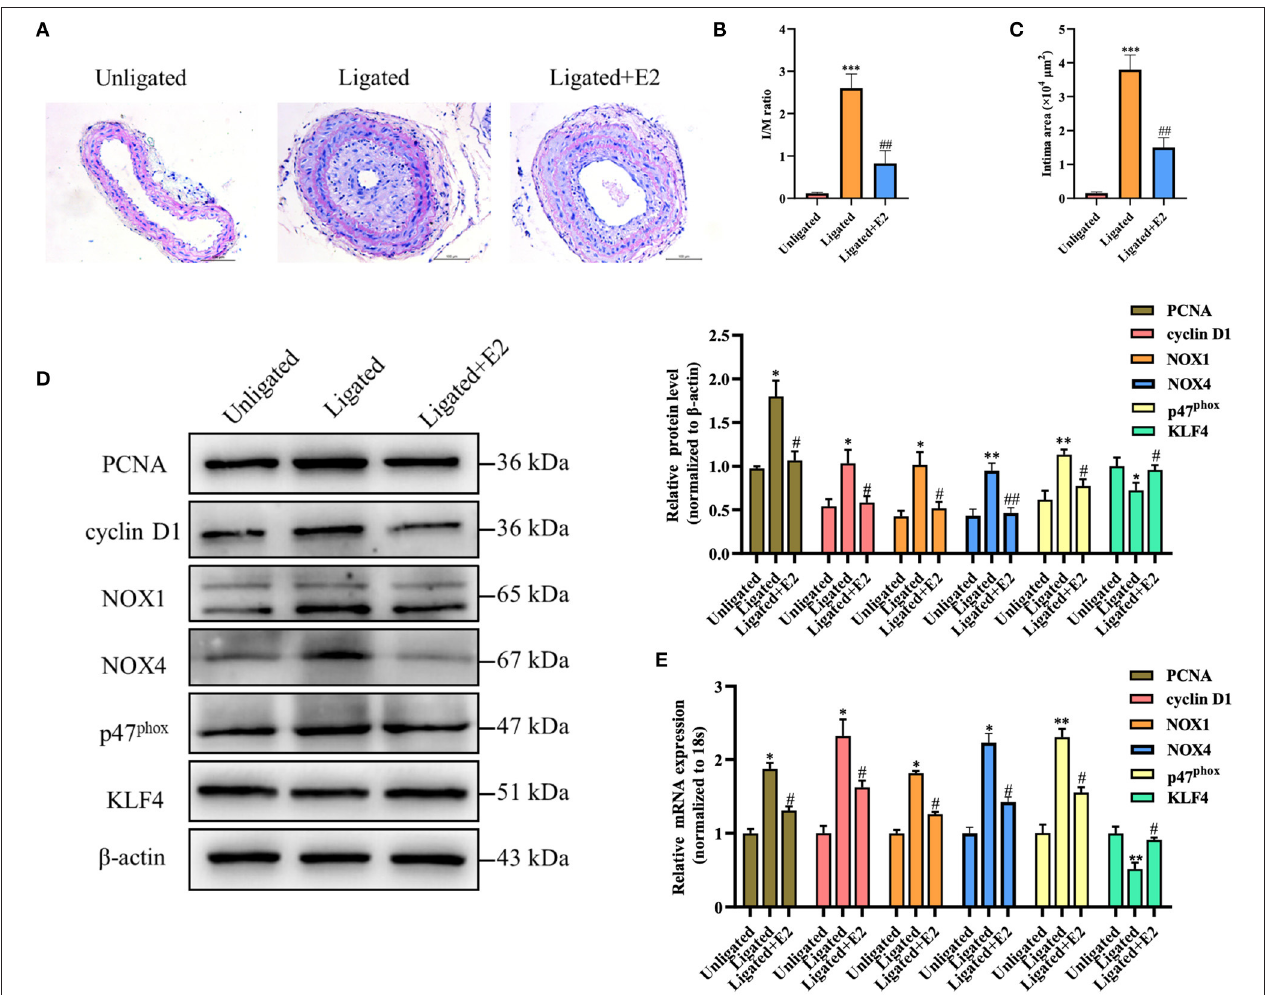
FIGURE 1 | E2 attenuates neointimal formation, proliferation and oxidative stress induced by carotid artery ligation. (A) Representative photomicrographs of the HE-stained sections of carotid arteries from unligated vessels, ligated vessels, and ligated vessels treated with E2 ( n = 4). Scale bars = 100 µ m. (B,C) Morphometric quantification of I/M ratio and the intima area in the different groups. *** p < 0.001 vs. Unligated group, ## p < 0.01 vs. Ligated group. (D) PCNA, cyclin D1, NOX1, NOX4, p47 phox and KLF4 expression in unligated, ligated and ligated + E2-treated carotid arteries was detected by Western blotting. Statistic of band intensities is shown on the right ( n = 3). * p < 0.05 and ** p < 0.01 vs. Unligated group, # p < 0.05 and ## p < 0.01 vs. Ligated group. (E) PCNA, cyclin D1, NOX1, NOX4, p47 phox and KLF4 expression in unligated, ligated and ligated + E2-treated carotid arteries was detected by qRT-PCR ( n = 3). * p < 0.05 and ** p < 0.01 vs. Unligated group, # p < 0.05 vs. Ligated